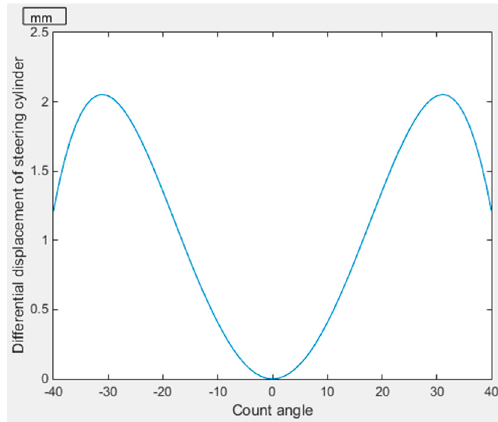
Figure 6. Curve of the stroke difference of a cylinder with steering angle.